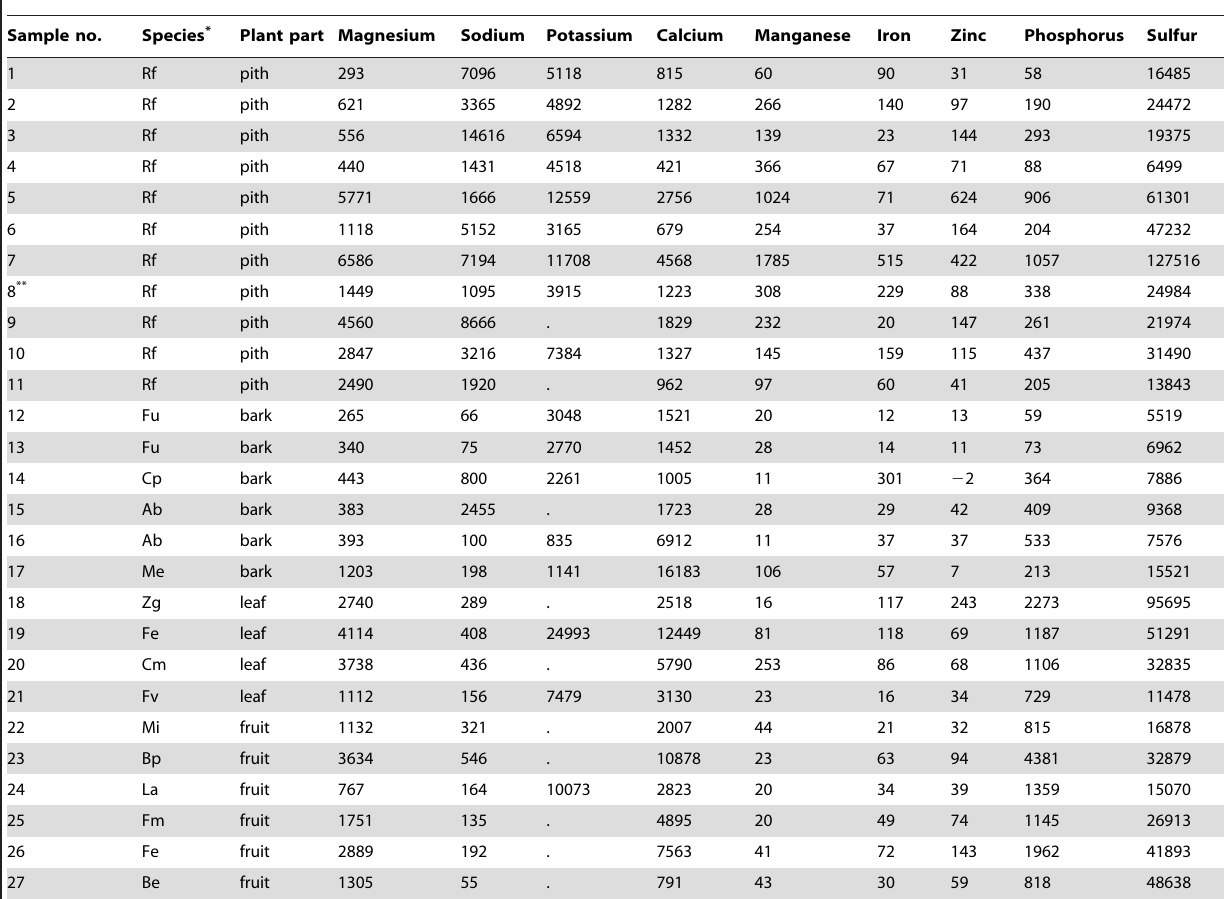
Table 1. Results (mg kg 2 1 ).